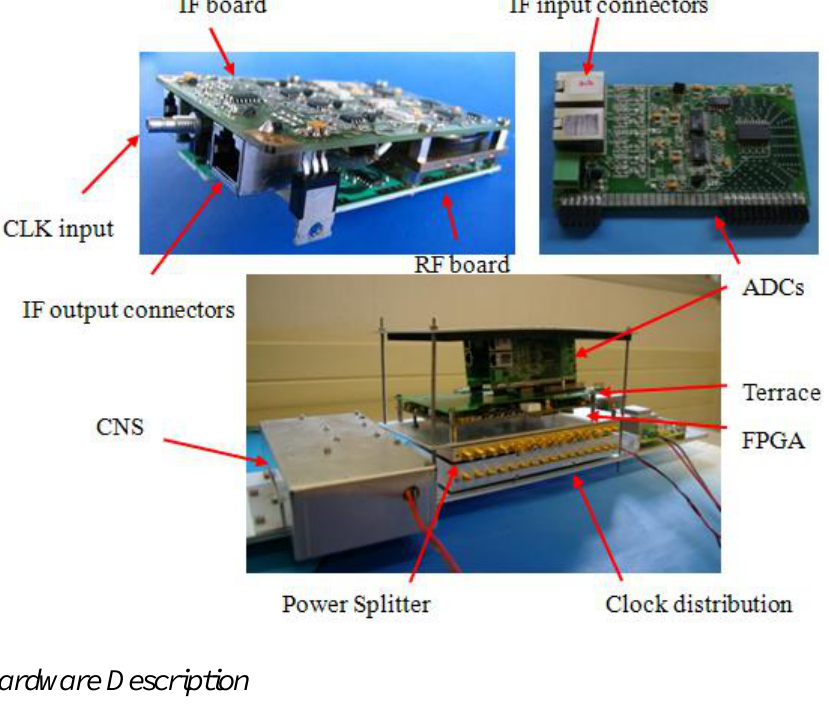
Figure 7. PAU sub-systems. (Top left) opened RF-IF dual-polarization receiver with four channels. (Top right) dual-channel ADC sub-system. (Bottom) processor terrace that is placed in the middle of the instrument (Figure 6) and contains the CNS, clock distribution, ADC set, clock reference, clock distribution, and FPGA where the digital hardware and the software algorithms are